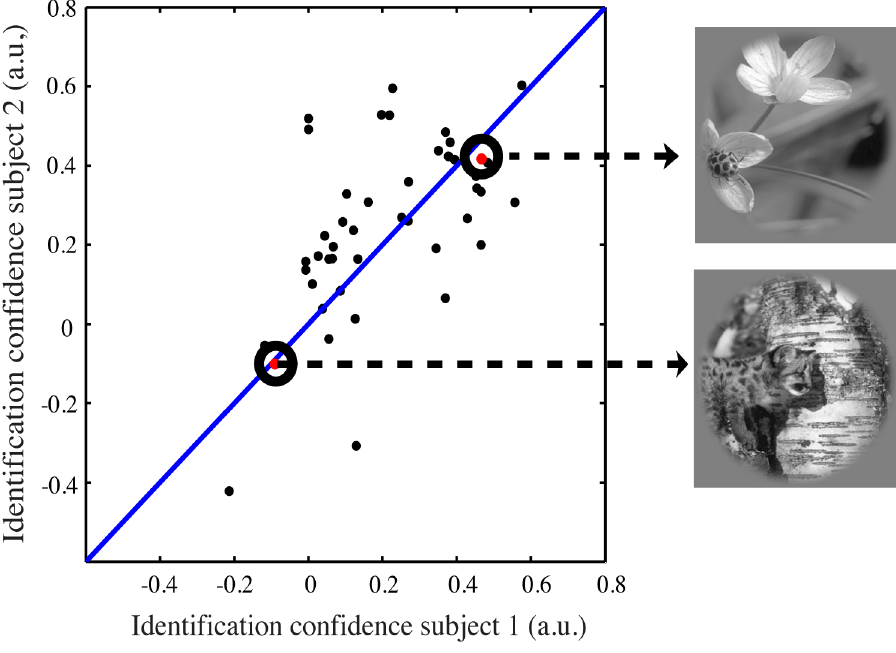
Fig 6. The identification confidence per natural image for our two subjects. Every dot representsan individual image. We see similar confidenceof the individualnatural images across the two subjects. Some images are identifiedless accuratelyusing the pRF-modelthan others. This is explainedby two factors: (i) certain images are more similar in terms of their contrast-energy content and (ii) responses to these images dependmore on features that are not captured by the contrast-energy